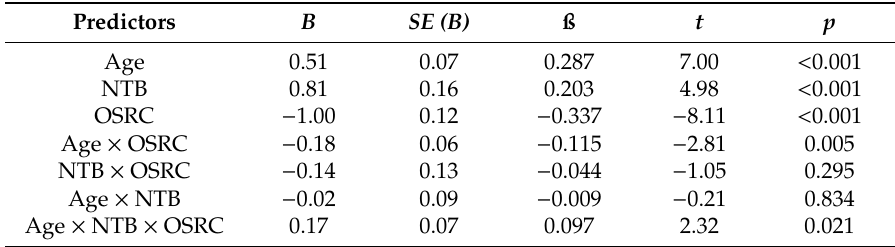
Figure 3. Simple Slopes visualizing the significant three-way interaction between age, need to belong (NTB), and online self-regulative competences (OSRC) in the prediction of social-networks-use disorder symptoms with ** p < 0.01, *** p < 0.001 and for all significant t : 2.65 ≤ t ≤ 6.78. Table 2. Regression coe ffi cients of the hierarchical moderated regression analysis with age, need to belong (NTB), and online self-regulative competences (OSRC) predicting symptoms of a social-networks-use